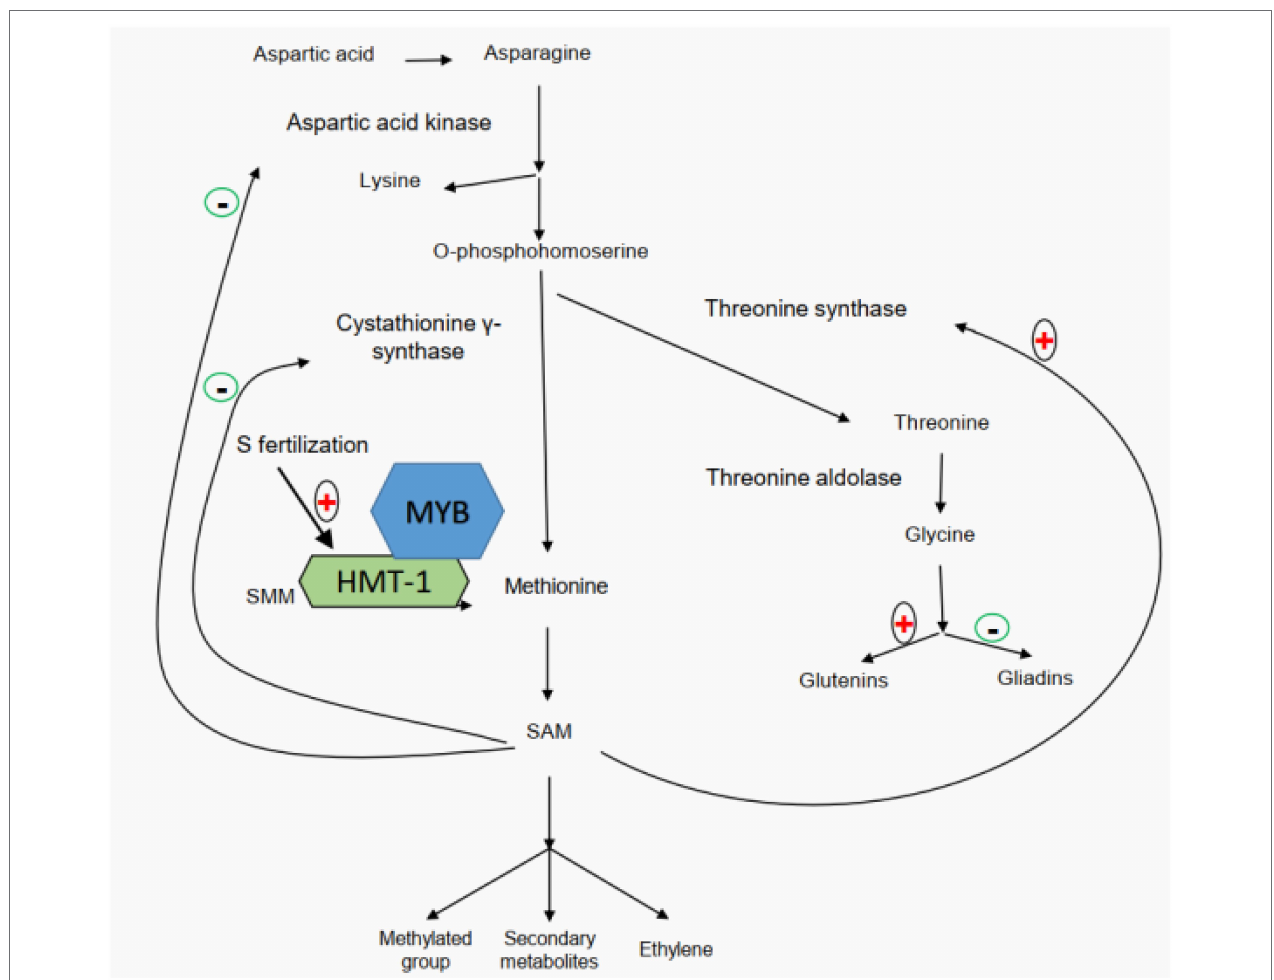
FIGURE 2 | Sulfur-mediated regulation network of wheat gluten component biosynthesis (modified from Yu et al., 2021).